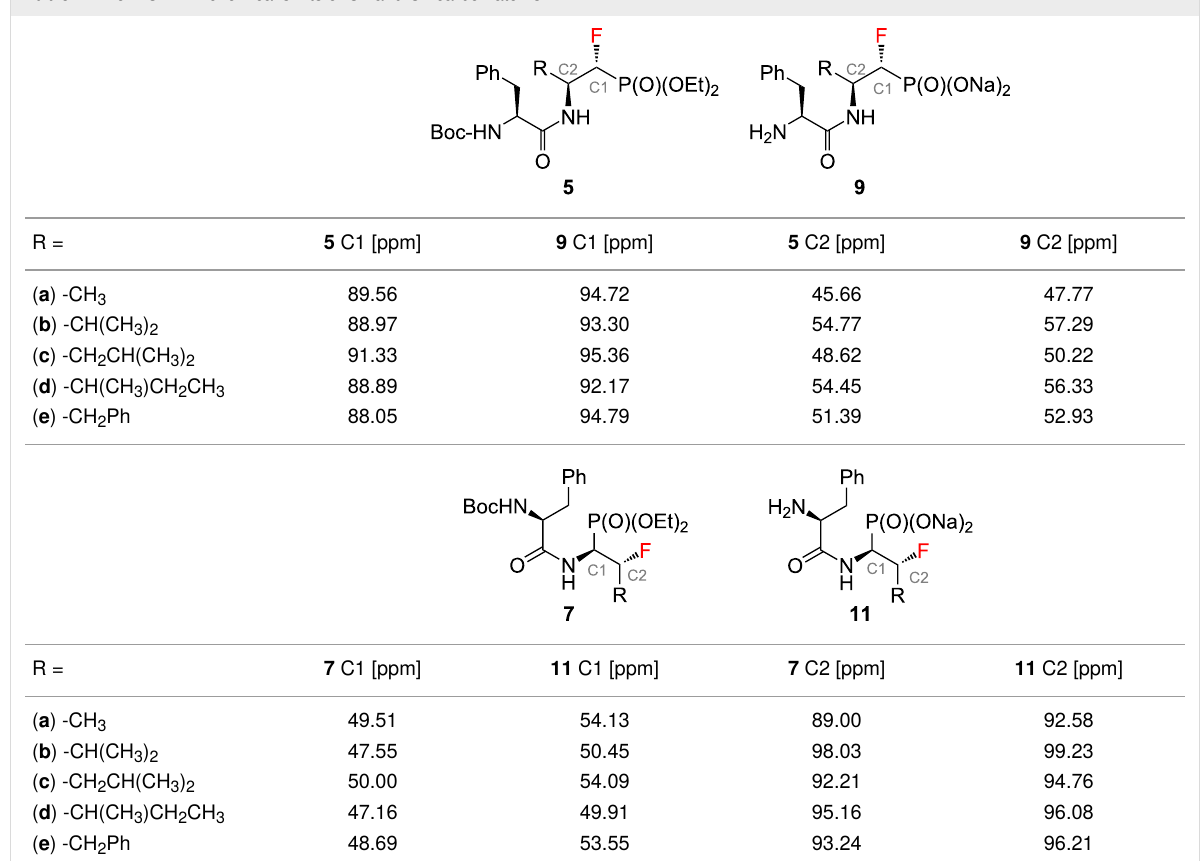
Table 1: The 13 C NMR chemical shifts of C1 and C2 carbon atoms.